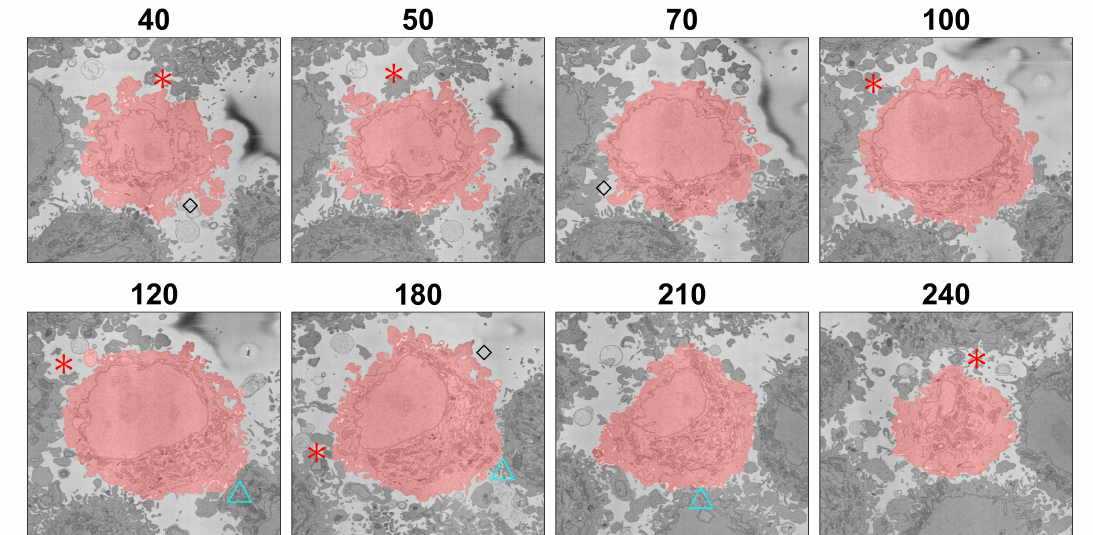
Figure 12. Illustration of the segmentation at several slices of one cell. The segmentation is indicated with a red shade over the cell. Red asterisks indicate regions where the segmentation did not include protuberances that could belong either to the cell or to neighbouring cells. Blue triangles indicate regions where two cells were close together and the segmentation tended to a straight line between the cells. Black diamonds indicate convoluted protuberances that were correctly segmented. The slice number relative to the stack of 300 is indicated above each